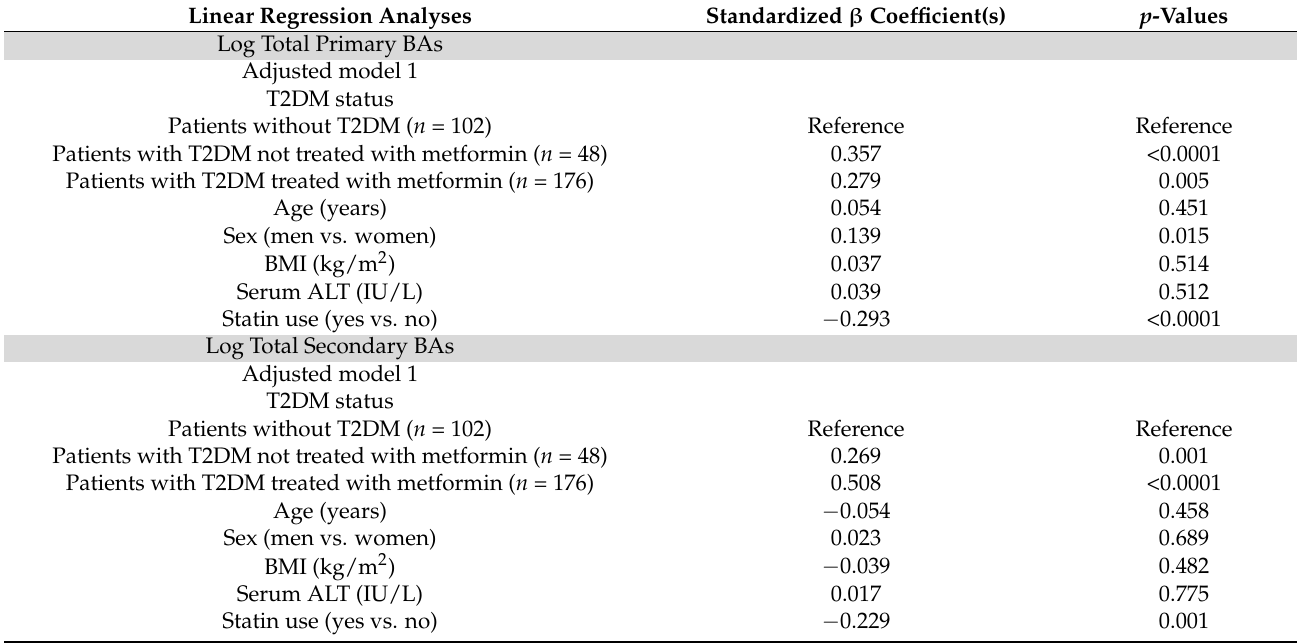
Table 4. Linear regression analyses—Adjusted associations between concentrations of primary and secondary bile acid concentrations and presence/absence of type 2 diabetes mellitus (T2DM) treated with or without metformin.